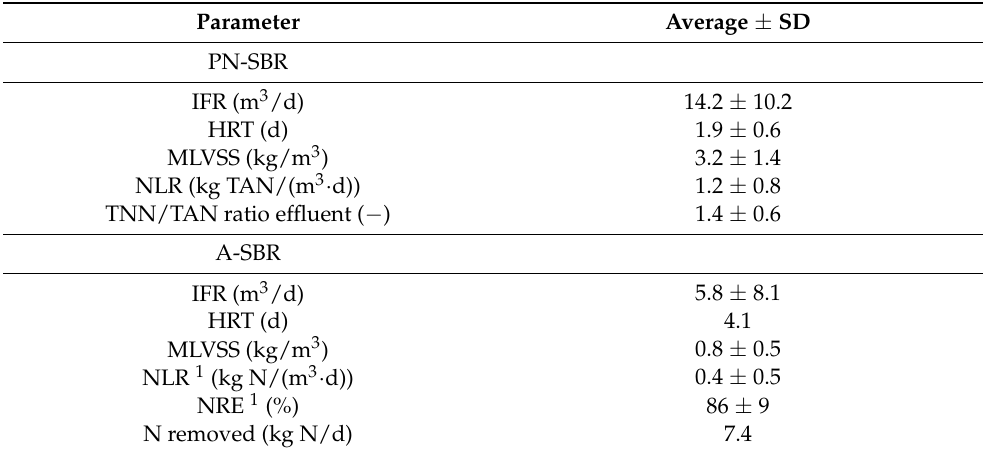
Table 2. Summary of the operational conditions applied in PN-SBR and A-SBR at the